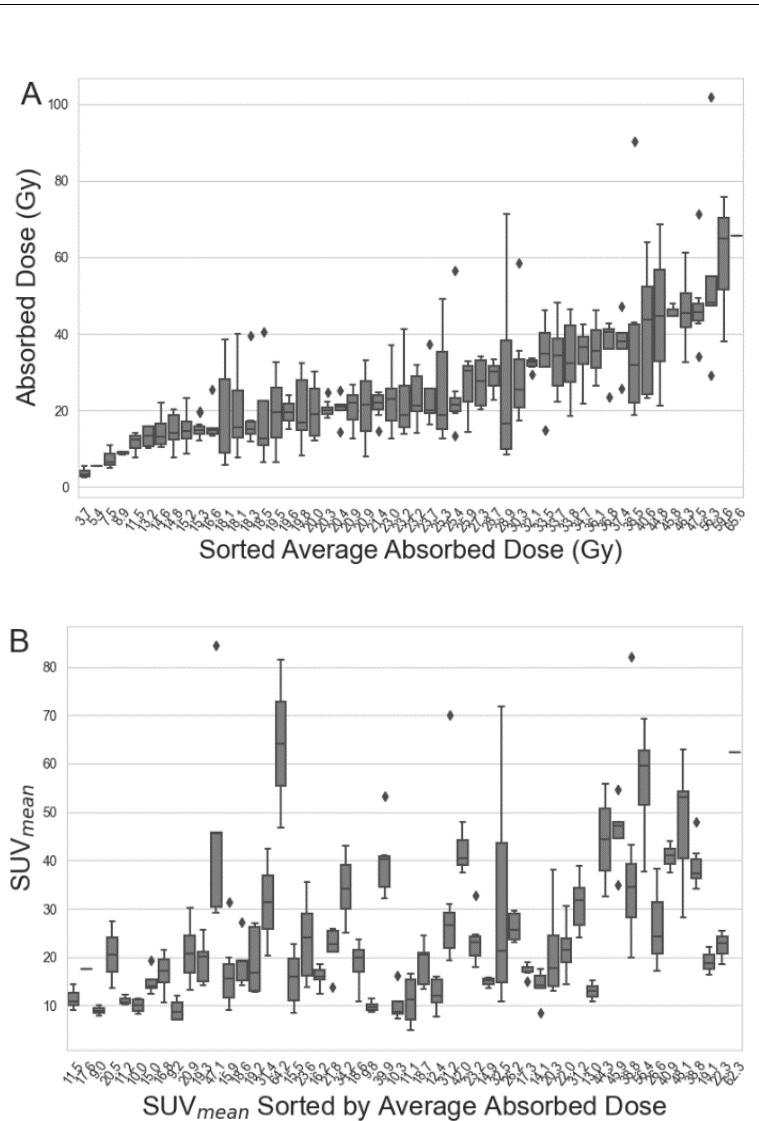
Figure 2. Box-and-whisker plots of [ 177 Lu]Lu-DOTA-TATE absorbed dose ( A ); and [ 68 Ga]Ga-DOTA- TOC SUV mean ( B ), representing all the analysed tumours in each patient. The patients are sorted by average tumour-absorbed dose in both figures.